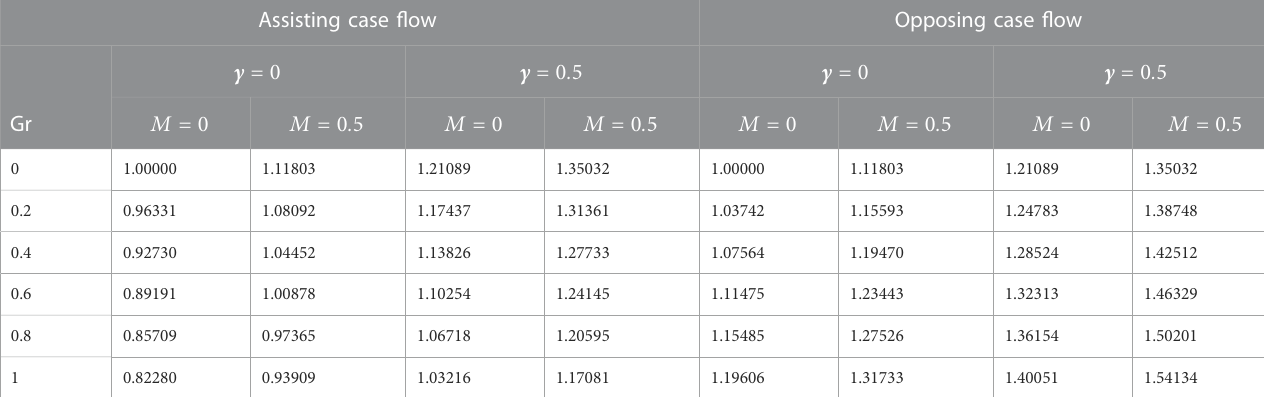
TABLE 2 Coef fi cient of skin friction for helping and obstructing fl ow.